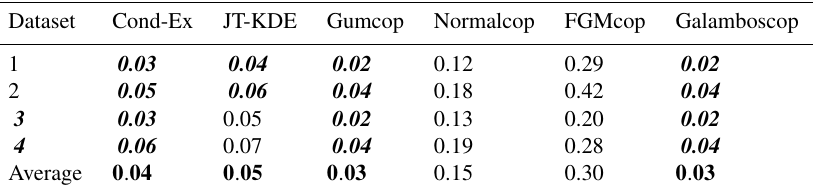
Table 6. Weighted Euclidian distance ( wd ) for datasets 1 to 4 based on extreme temperature wildfire and six models, along with confidence scores (average of the wd for datasets 1 to 4). In italic bold are highlighted the values below the naïve approach wd , and the average values of the four models with confidence scores < 0 . 1 are highlighted in